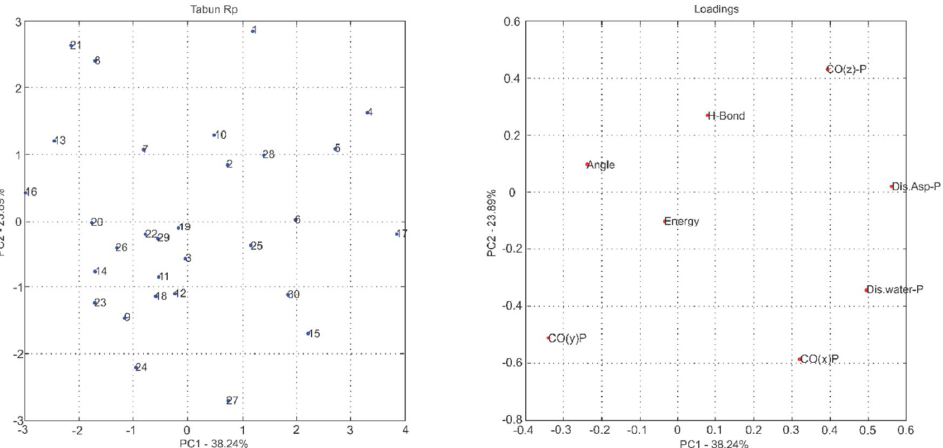
Figure 7. PC1 versus PC2 projection for Soman ( S P enantiomer) and loadings graph of the variables investigated ( left and right , respectively).